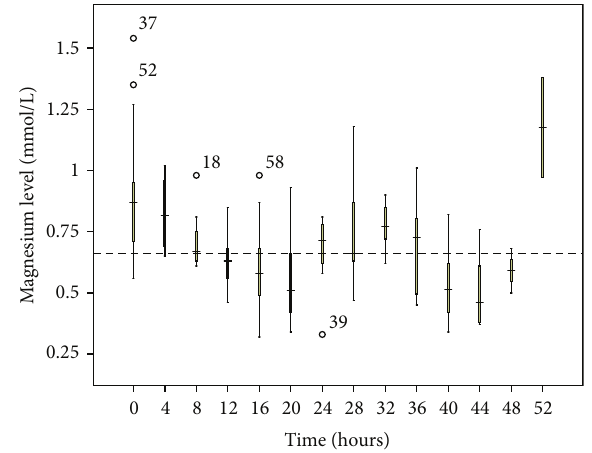
Figure 6: Potassium changes over time during citrate CRRT. Standard box plot in which the horizontal line represents the median,thethicklinerepresentstheinterquartilerange,andthethin line represents the maximum and minimum values. The circular dots represent the outliers.